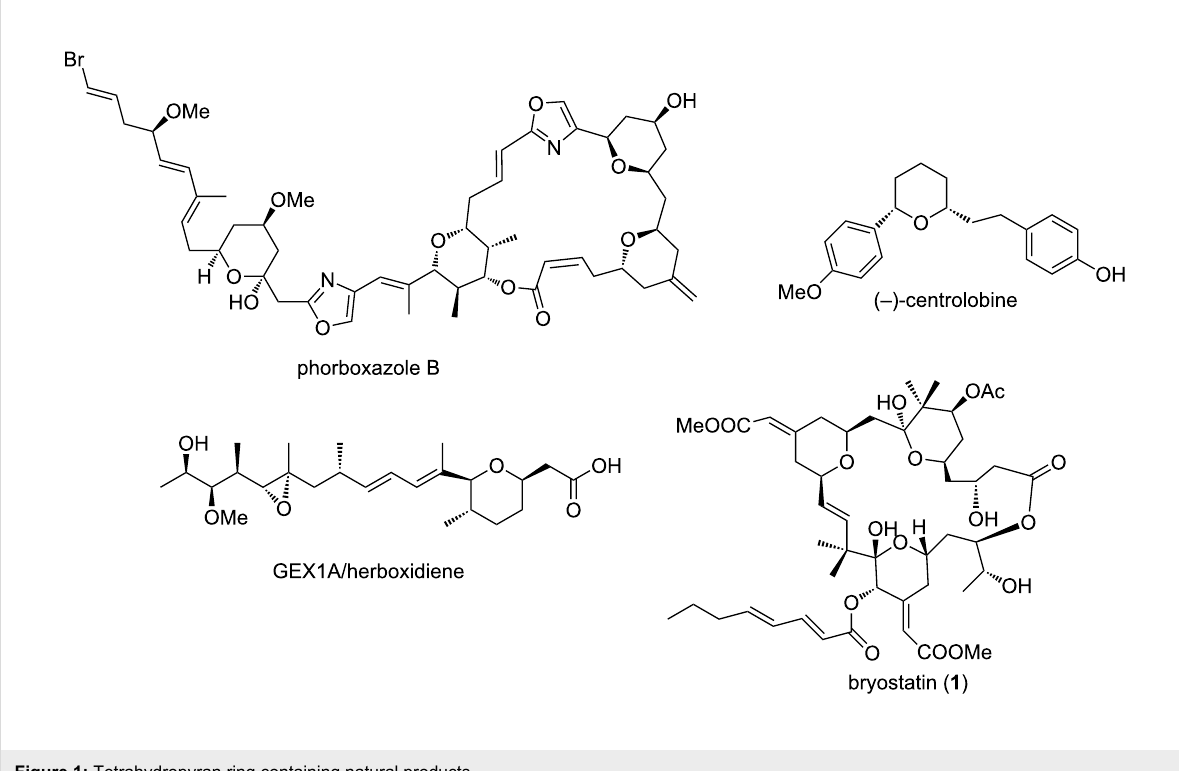
Figure 1: Tetrahydropyran ring containing natural